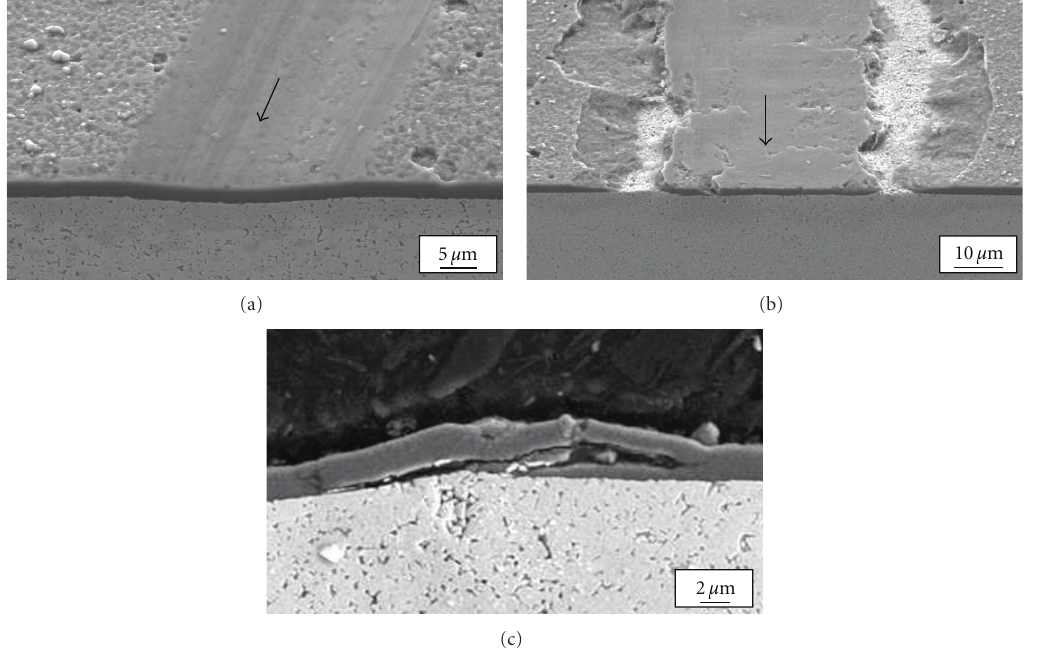
Figure 8: Cross-sections of the circular wear tracks illustrating (a) plastic deformation and minor cracking (no coating material detached), (b) continuous interfacial spalling (adhesive failure), and (c) interfacial cracking at the rim of a scratch track for Ti 0 . 34 Al 0 . 66 N coating. The arrows indicate the scratching